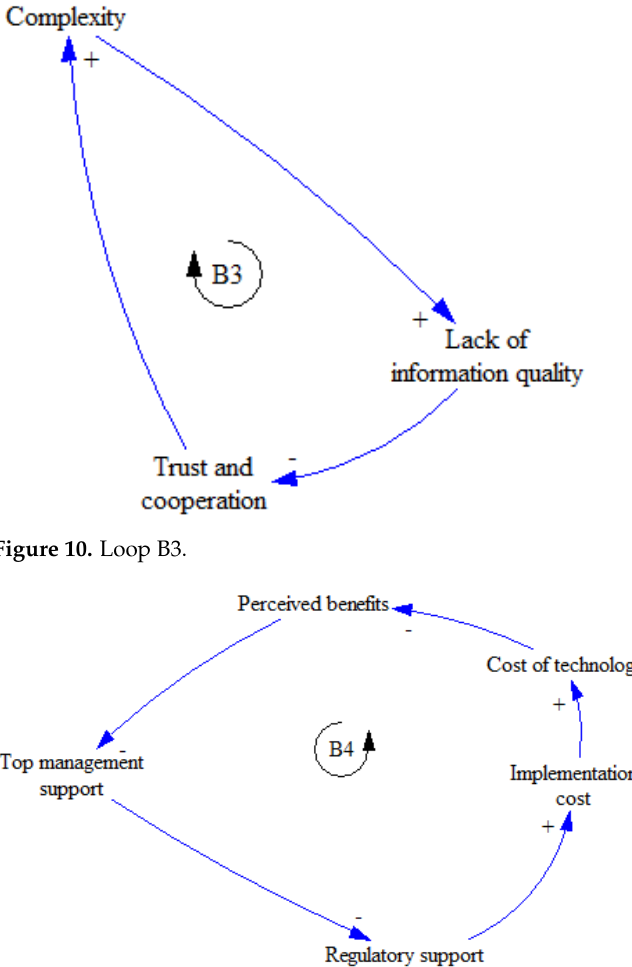
Figure 10. Loop B3.